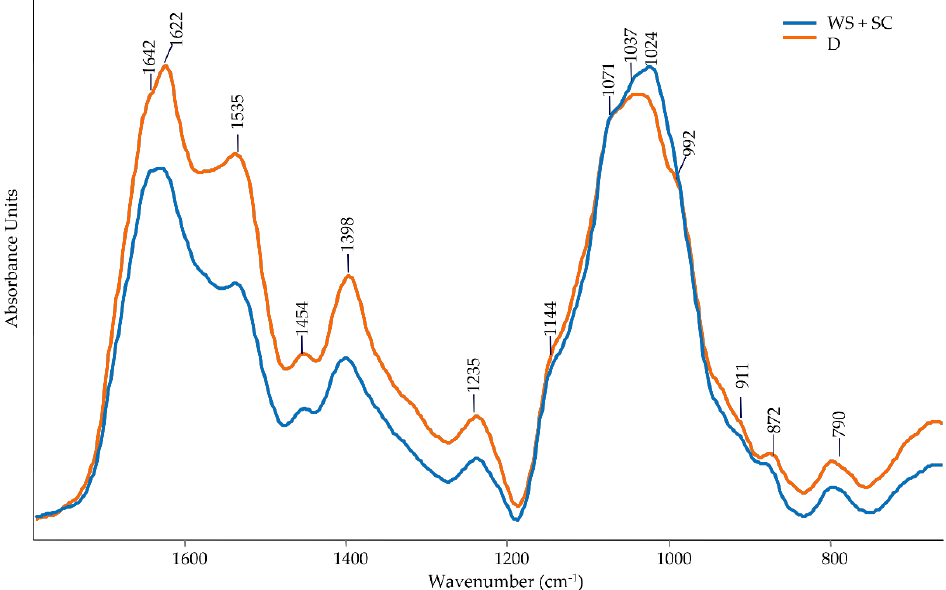
Figure 9. ATR-FTIR spectra (1800–700 cm − 1 ) of the polysaccharides extracted from fruiting bodies of P. ostreatus harvested from the two growing substrates WS + SC (blue line) and D15 (orange line).